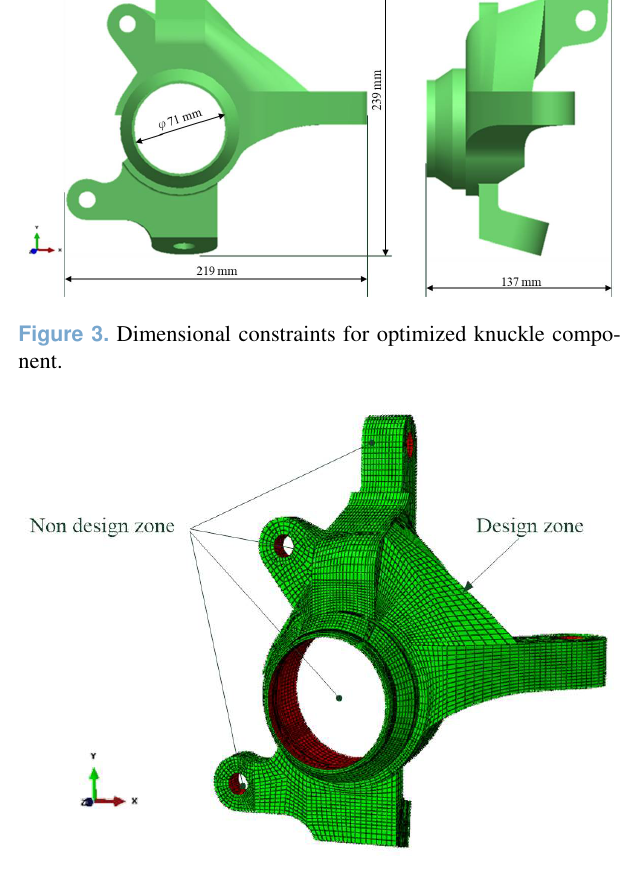
Figure 4. Structural planning of knuckle prototype.